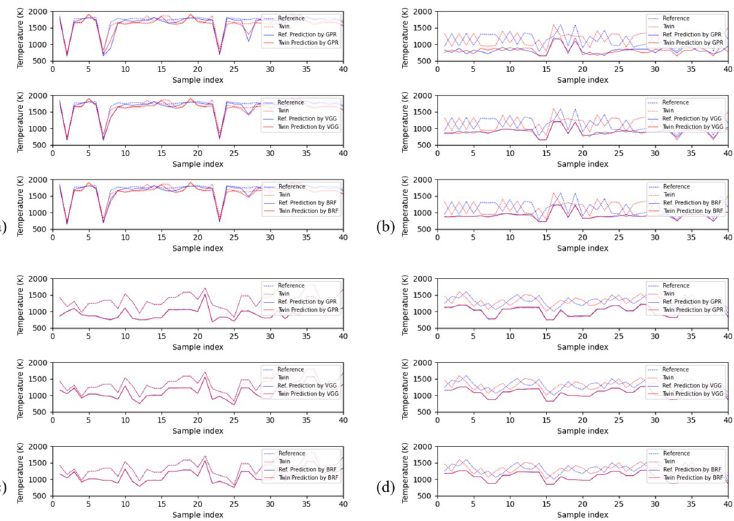
Fig 6. Examples of performances of the models on spectral twins. In each figure, the top, middle and bottom subplots are the predictions of GPR, VGG and BRF, respectively. (a) First 40 twins with the smallest temperature difference at the similarity level of 10 − 3 . (b) First 40 twins with the biggest temperature difference at the similarity level of 10 − 3 . (c) First 40 twins with the smallest temperature difference at the similarity level of 10 − 5 . (d) First 40 twins with the biggest temperature difference at the similarity level of 10 − 5